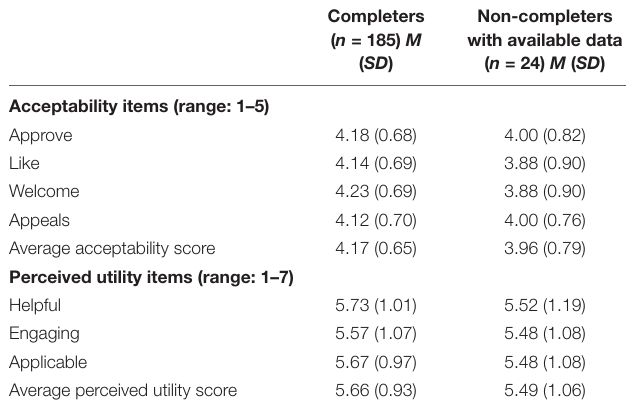
TABLE 2 | Acceptability and feedback ratings on single-session